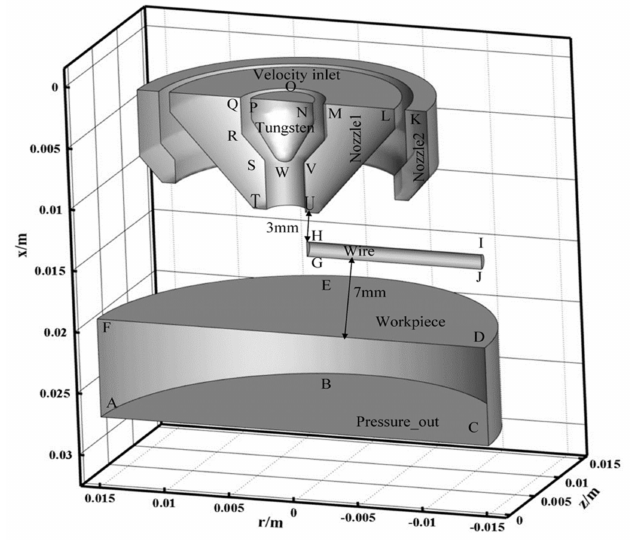
Figure 3. Computational domain